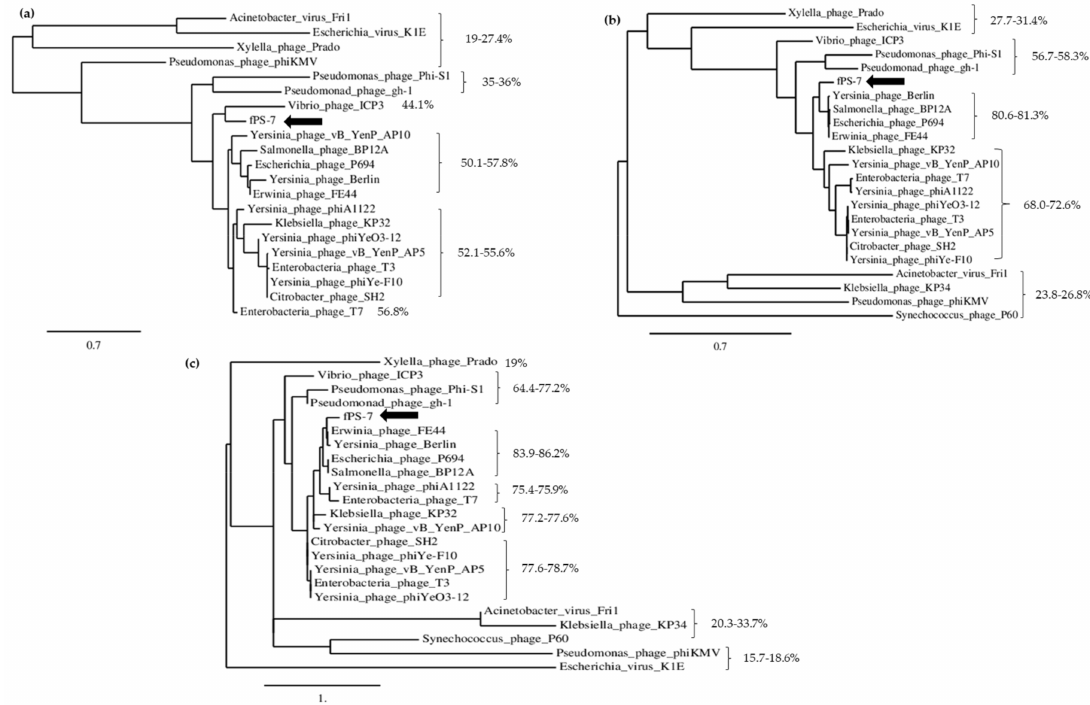
Figure 4. Phylogenetic tree analysis based on the alignments of amino acid sequences of DNA ligases ( a ), RNA polymerases ( b ) and capsid and scaffolding proteins ( c ) of Autographivirinae subfamily phages using BLASTP for the alignment and Phylogeny.fr for the phylogenetic tree construction. The black arrows indicate phage fPS-7. The identity-percentages of the three proteins of different phages to the proteins of fPS-7 are